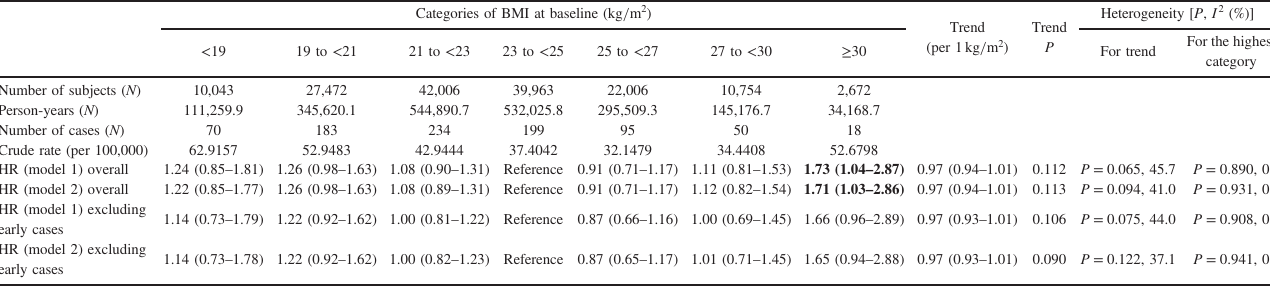
Heterogeneity [ P , I 2 (%)] Trend Trend Forthe highest P (per 1kg = m 2 ) category